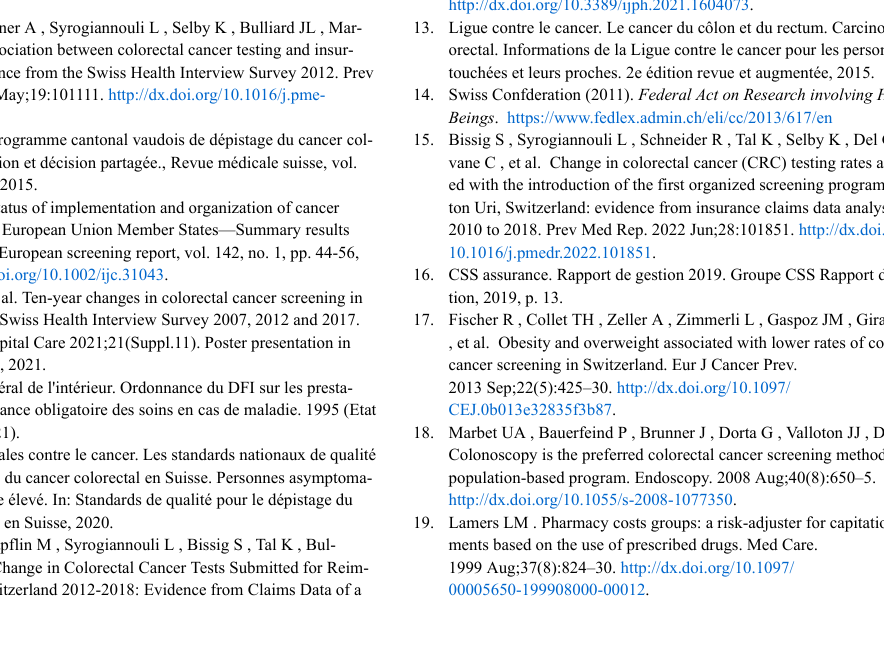
Table 4: Odds ratio of being tested for colorectal cancer within each calendar year (2011–2018) for 50–69-year-old insurees, in (A) any test for colorectal cancer (faecal occult blood test or colonoscopy)*, (B) faecal occult blood test** or (C) colonoscopy**, in canton Vaud compared to neighbouring cantons before and after the launch of the Vaud organised screening programme in 2015. CSS